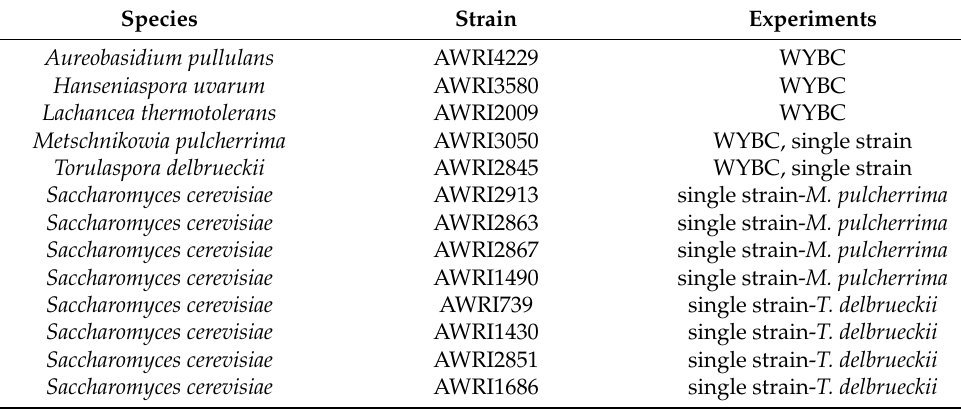
Table 1. Yeast strains used in this